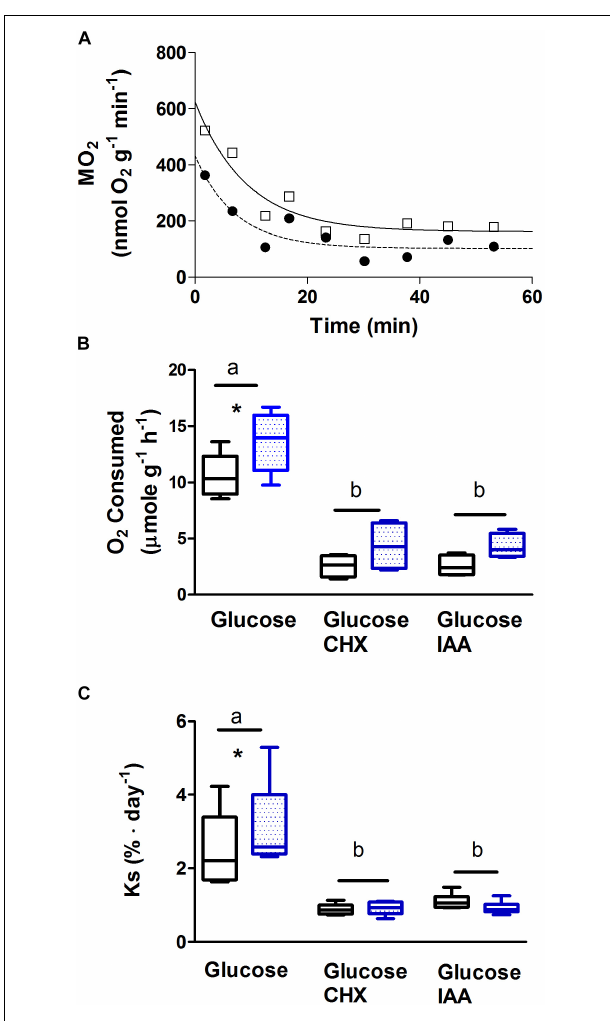
FIGURE 3 | Rate of oxygen consumption and protein synthesis by isolated mantle muscle strips from cuttlefish ( Sepia officinalis ). One of two paired mantle strips was stimulated to contract for 30 s at 3 Hz simulating jetting behavior. Oxygen consumption and protein synthesis was then measured during the recovery period. (A) Representative trace of rate of oxygen consumption. The curve with squares and solid line represents oxygen consumption by a mantle preparation that had been forced to contract; the dashed line with circles is the matched unstimulated paired preparation. (B) Average rate of oxygen consumed over a 40–60 min period following contraction. (C) Rate of protein synthesis measured over a 1 h period following contraction. Open bars represent unstimulated preparations; stippled bars indicate preparations that were stimulated. Text below x -axis shows additions to media. For CHX and IAA additions, preparations were incubated for 10 min prior to stimulation, during stimulation, and throughout the post contraction incubation period. For ˙M O 2 measurements N = 7 for glucose; N = 4 for CHX and IAA. For protein synthesis N = 6 in all cases. Values with different letters are significantly different. ∗ Significant difference between unstimulated and stimulated preparations. Box and whisker plots show the range and median